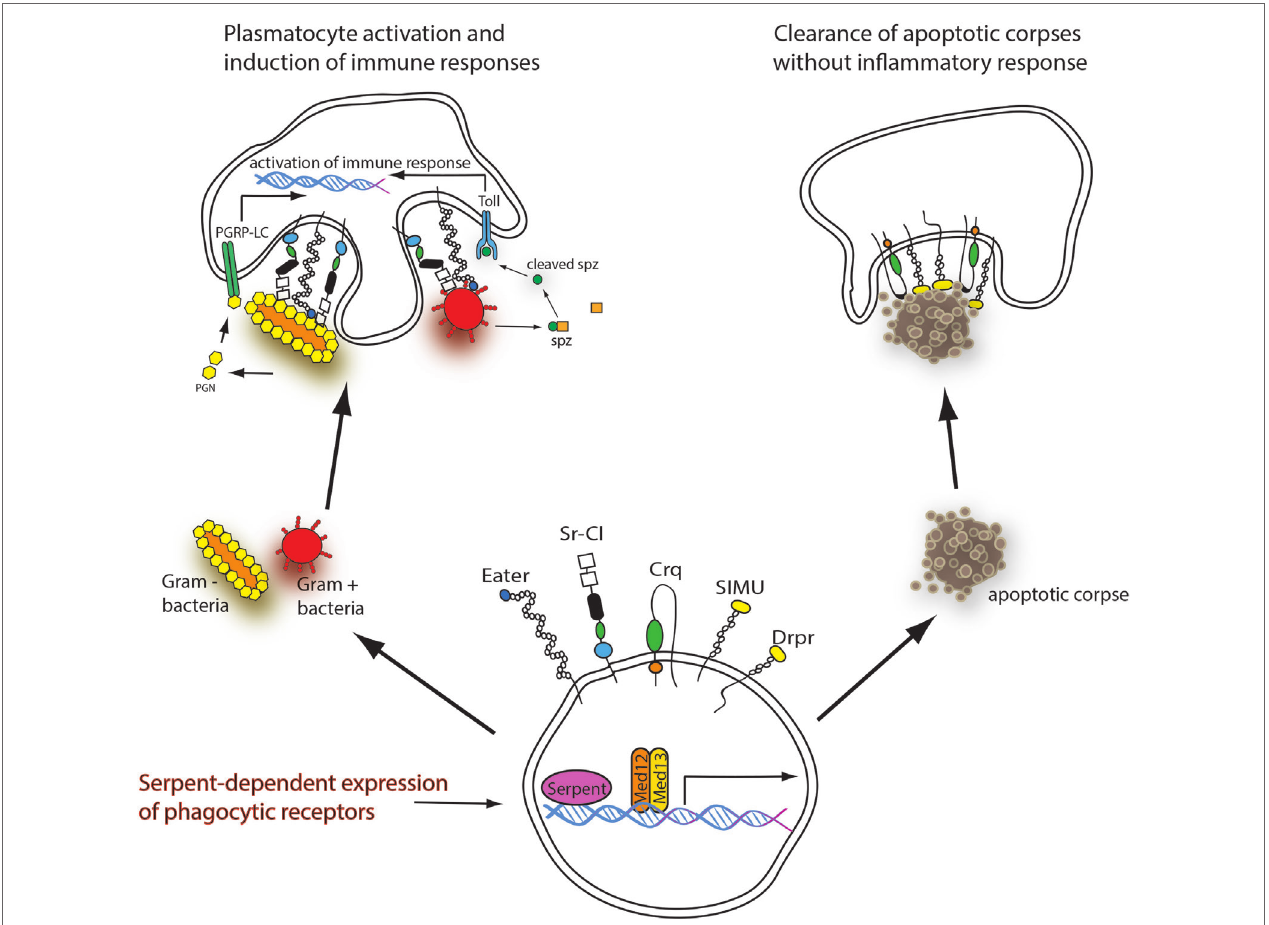
FiGure 1 | Serpent-dependent expression of phagocytic receptors. The naïve hemocyte expresses both apoptotic and immune-related phagocytosis receptors in a Serpent and Med12/Med13-dependent manner. Upon recognition of “eat me” signals produced by apoptotic corpses, the receptors Croquemort (Crq), Draper (Drpr), and Six-Microns-Under (SIMU) bind to the apoptotic corpse and initiate its phagocytosis and degradation without inflammatory response (right). When the hemocyte meets bacteria, the phagocytic receptors Eater and scavenger receptor CI (Sr-CI) bind to the bacteria initiating phagocytosis. Bacteria also induce systemic and cellular immune responses via the Imd and the toll pathways